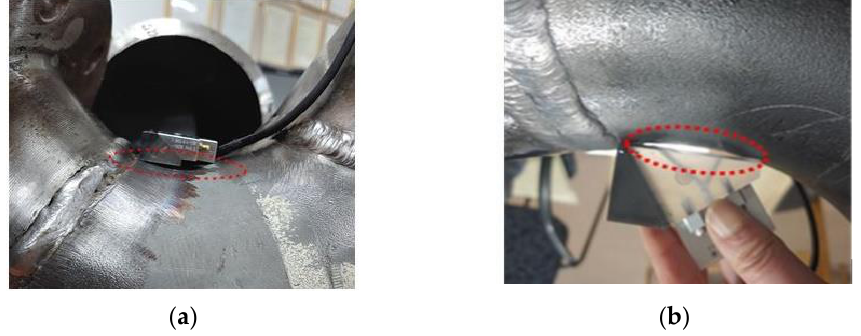
Figure 2. Images of the geometry of the accessibility limitation and non-contact by standard wedge PA probes on elbow curvature of pipe: ( a ) non-contact image by solid wedge fastening to conventional smallest PA probe in flange – elbow curved pipe; ( b ) difficulty in surface contact as the size of the rigid wedge mounted to the PA probe increases.